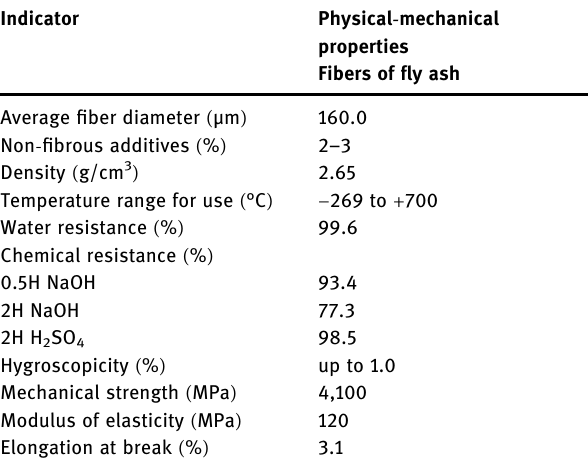
Table 3: Characteristics of the fi bers of fl y ash from TPPs